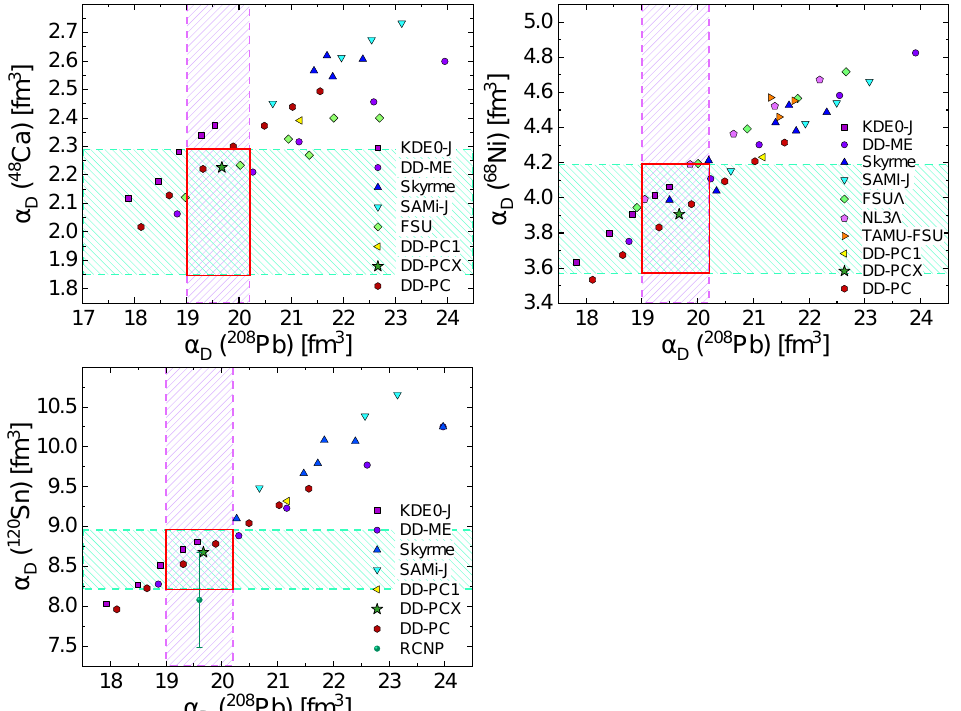
Figure 6. Comparison of the theoretical results for the dipole polarizability with the experimental data for 48 Ca- 208 Pb, 68 Ni- 208 Pb, and 120 Sn- 208 Pb. The theoretical results for the KDE0-J, DD-ME, Skyrme, SAMI-J, NL3 Λ , and FSU functionals are taken from Reference [60]. The experimental data with the error bars are shown as the shaded regions over the graph. The experimental data for 48 Ca ( α = 2.07 ± 0.22 fm 3 ), 68 Ni ( α = 3.88 ± 0.31 fm 3 ), and 208 Pb ( α = 19.6 ± 0.6 fm 3 ) are D D D taken from References [55], [56,60], and [59,60], respectively. For 120 Sn, the experimental value from References [57,60] ( α D = 8.59 ± 0.37 fm 3 ) is also shown using the shaded regions, and the recent data from Reference [58] ( α D = 8.08 ± 0.6 fm 3 ) is displayed with a green shaded